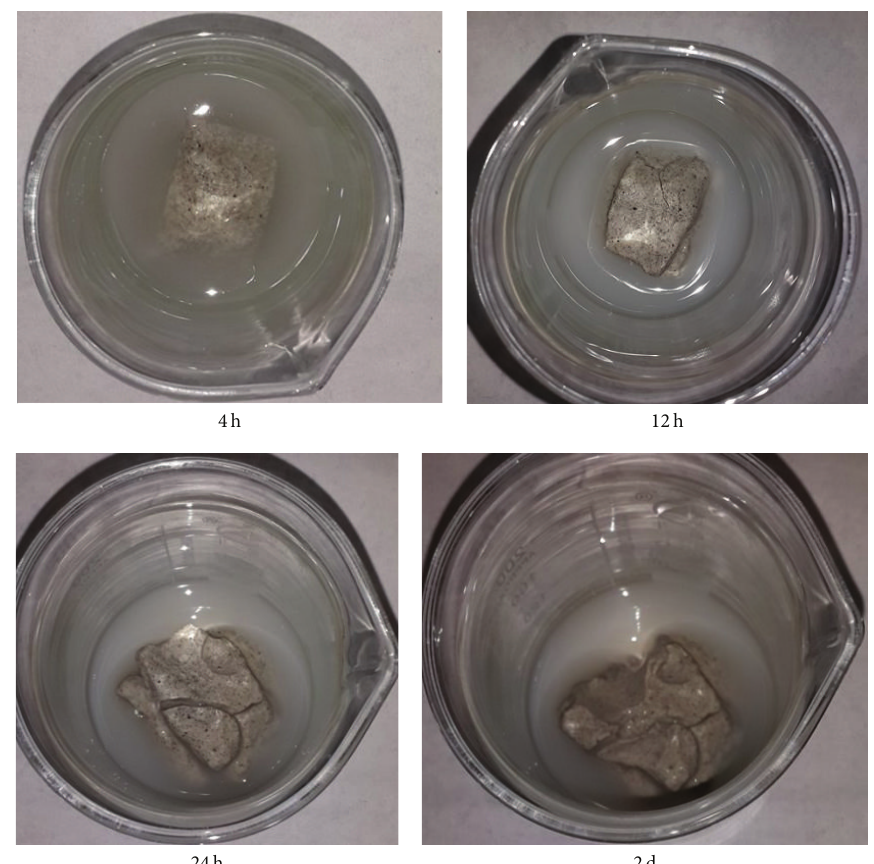
Figure 6: Water-induced weakening process of